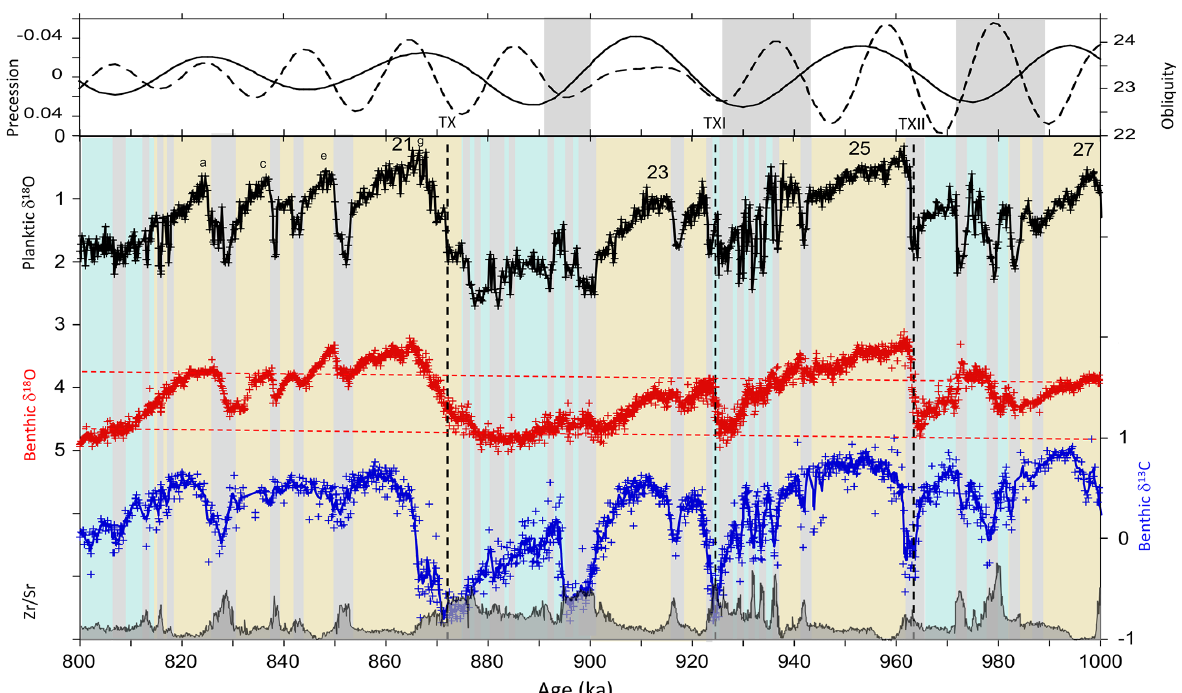
Figure 10. Same as Fig. 6 but for 600–1000ka, which includes the “900kyr” interval that clearly consists of two obliquity cycles with strong MCV on the MIS 25–24 transition.